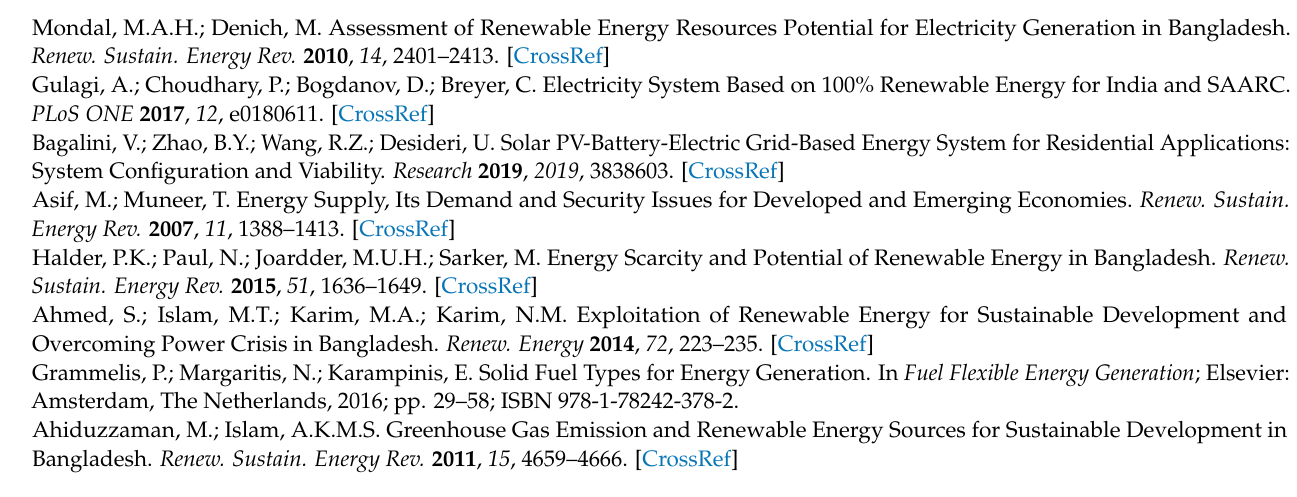
Figure S3: Solar irrigation project in Bangladesh [80]; Figure S4: Solar mini-grid in Monpura island of Bangladesh